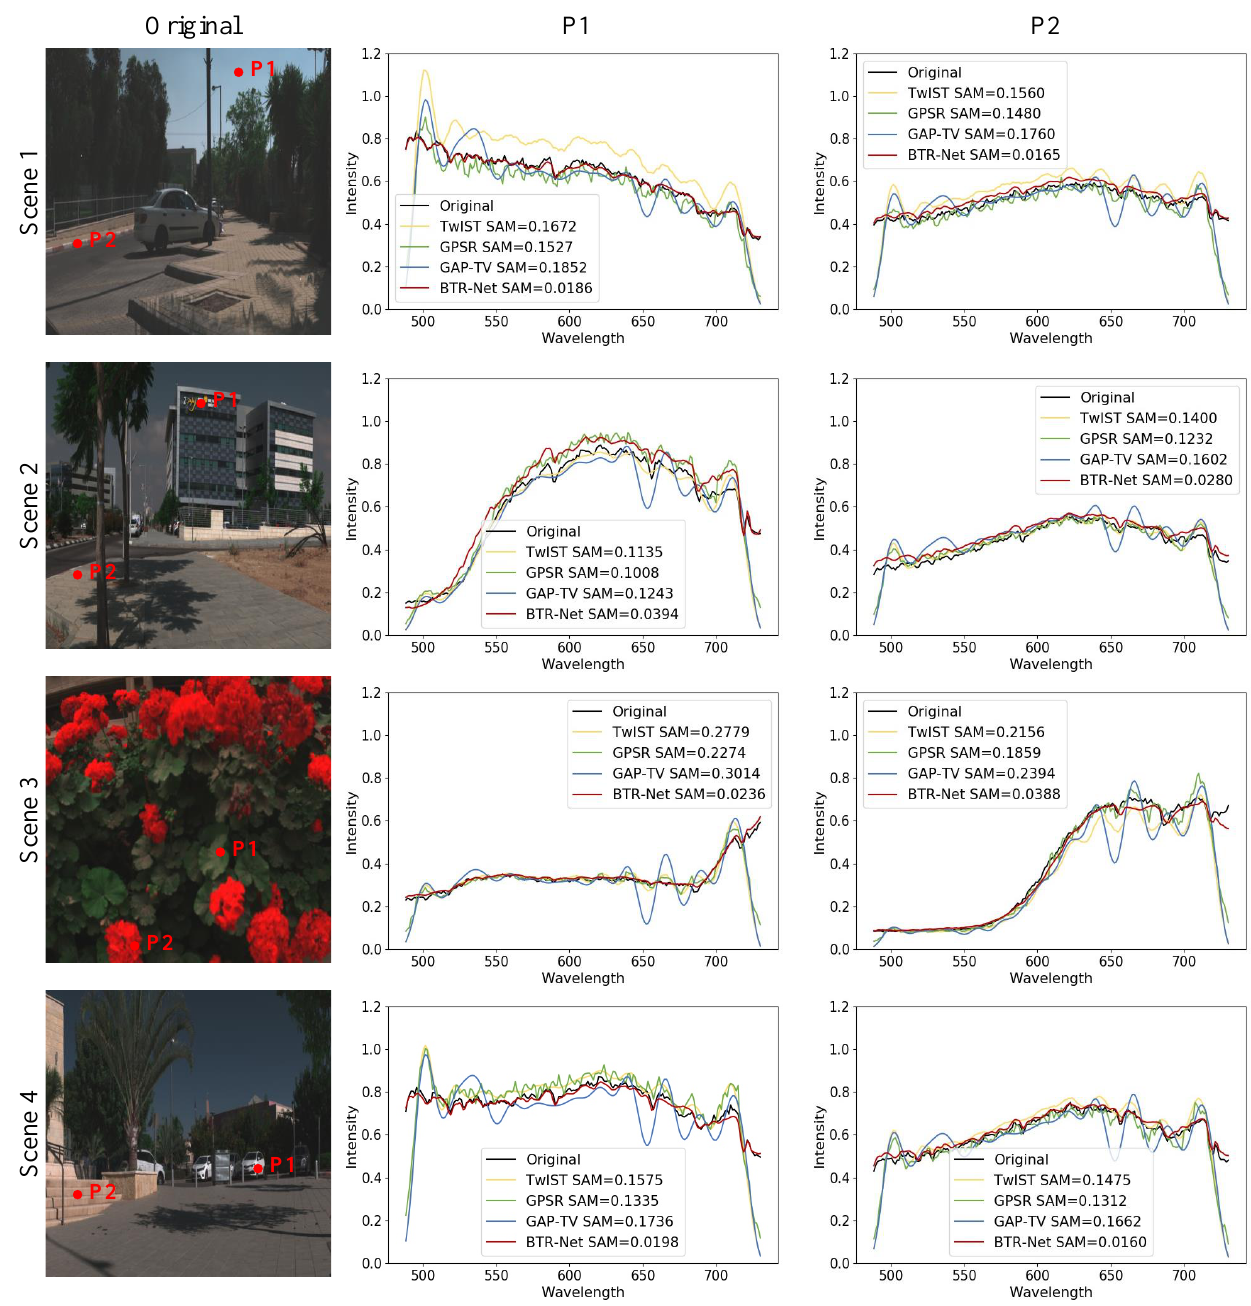
Figure 5. Comparisons of spectrum